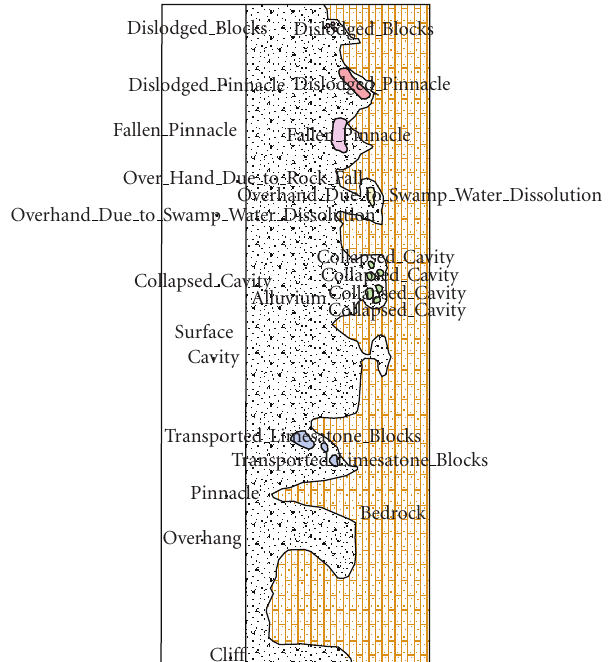
Figure 2: Some profiles of subsurface karstic